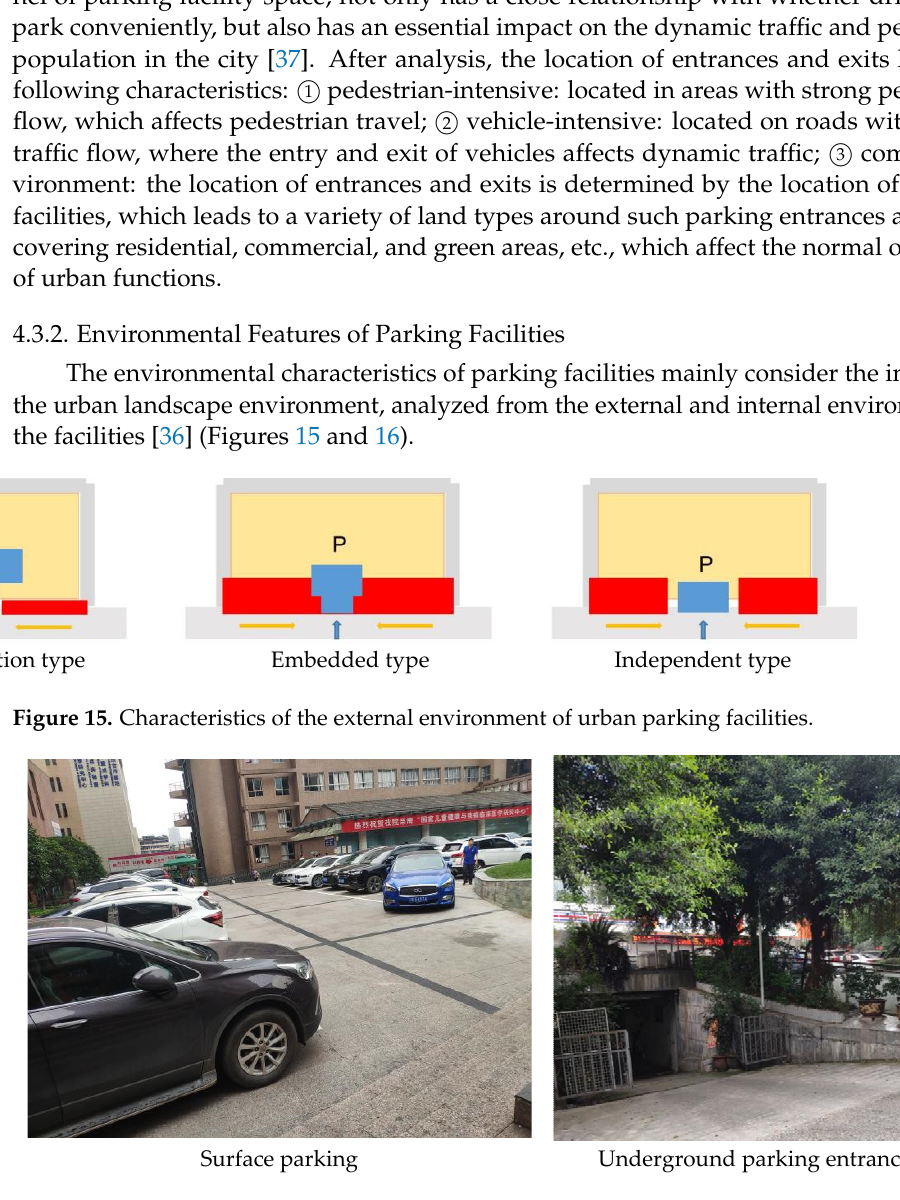
Figure 16. Characteristics of the internal environment of urban parking facilities.